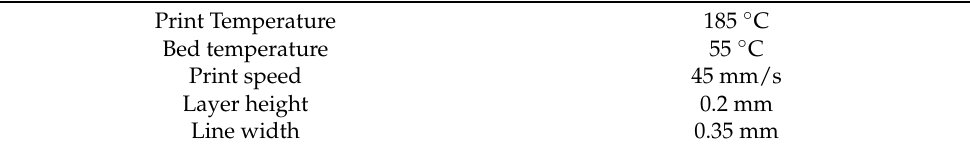
Table 1. PLA sample print settings.